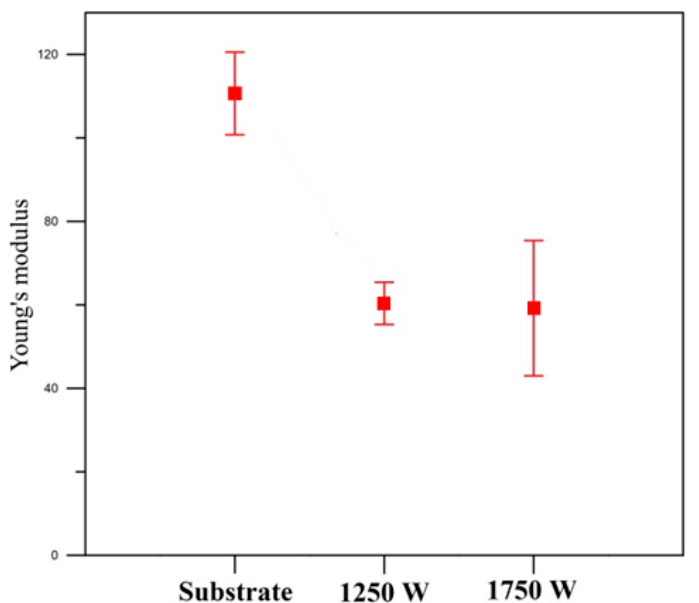
Figure 6. Young’s modulus of the Ti substrate and the Ti–Ta surface alloys formed by a beam power of 1250 and 1750 W.